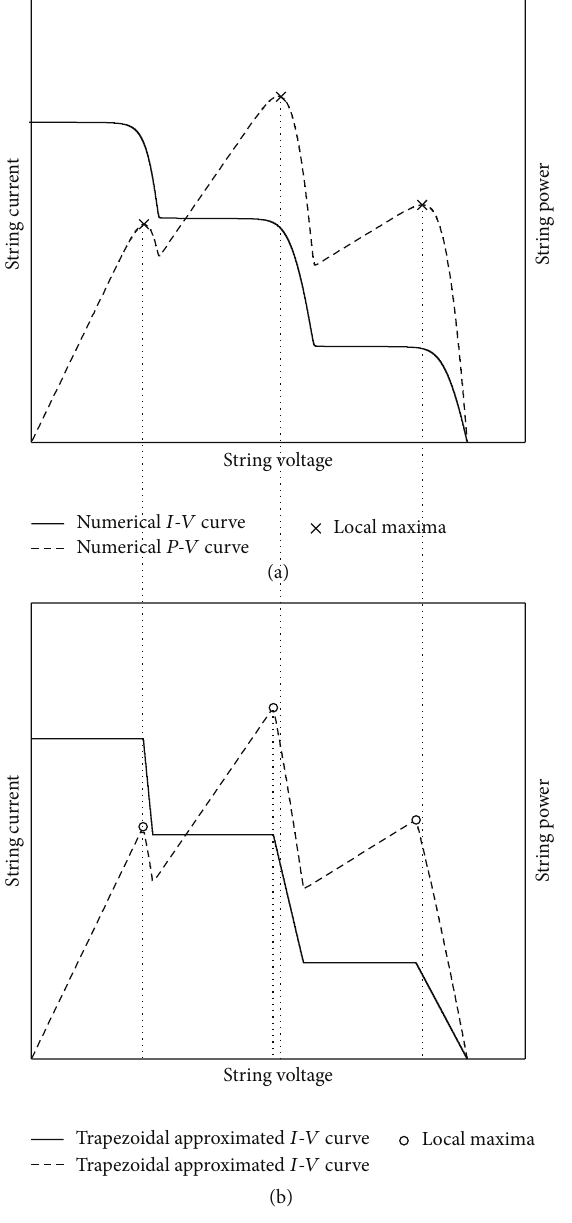
Figure 2: (a) Simulated I-V (solid line) and P-V (dashed line) curve. (b) Trapezoidal approximation of both I-V (solid line) and P-V (dashed line) curve. Cycles indicate the local